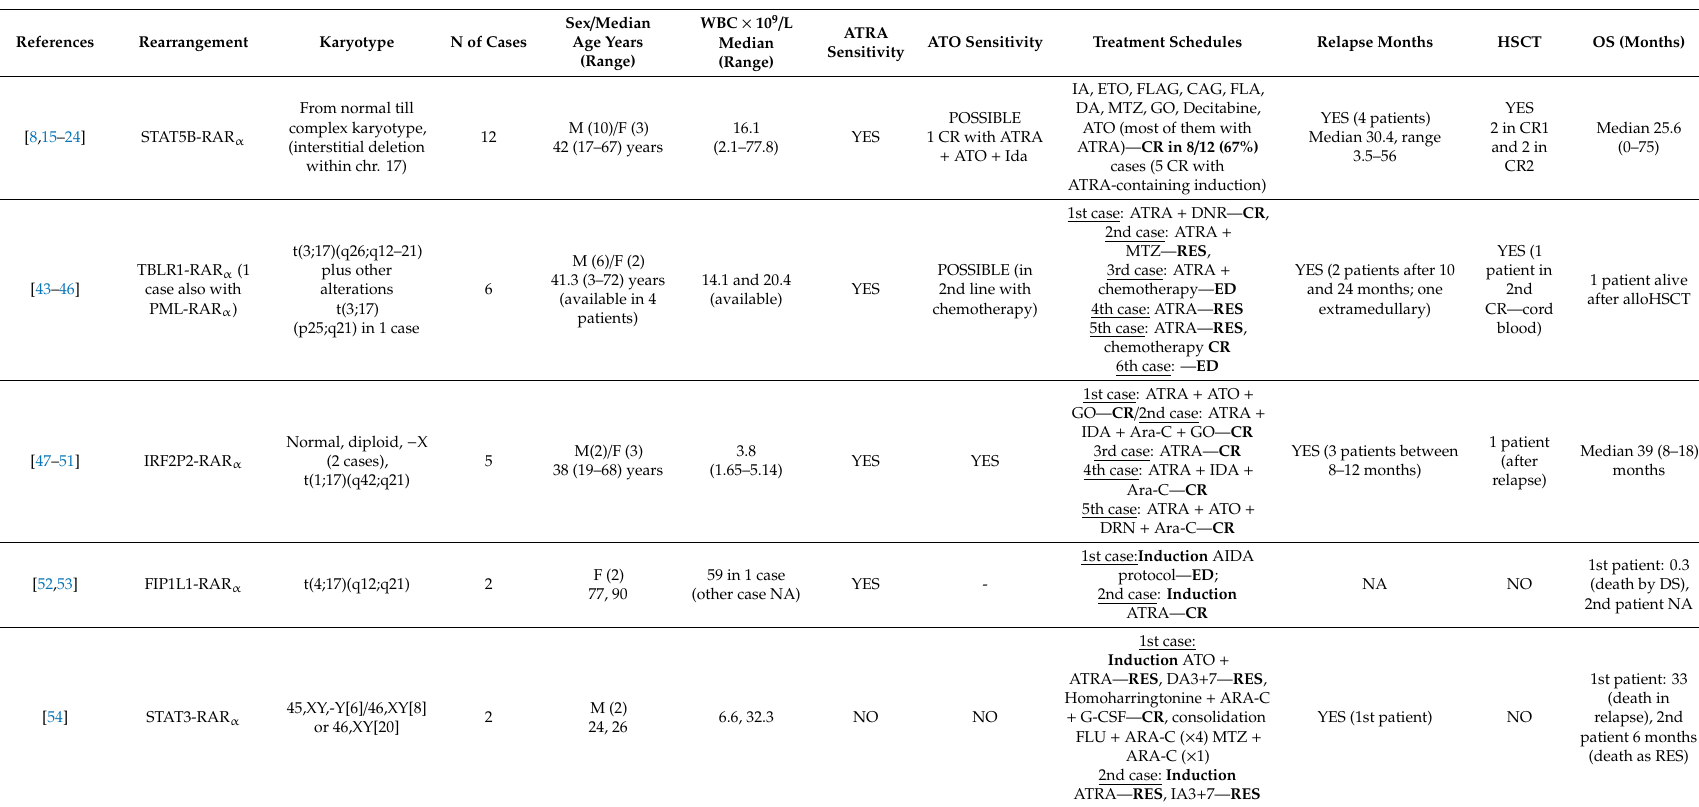
Table 4. Cases reported in the literature with other variant